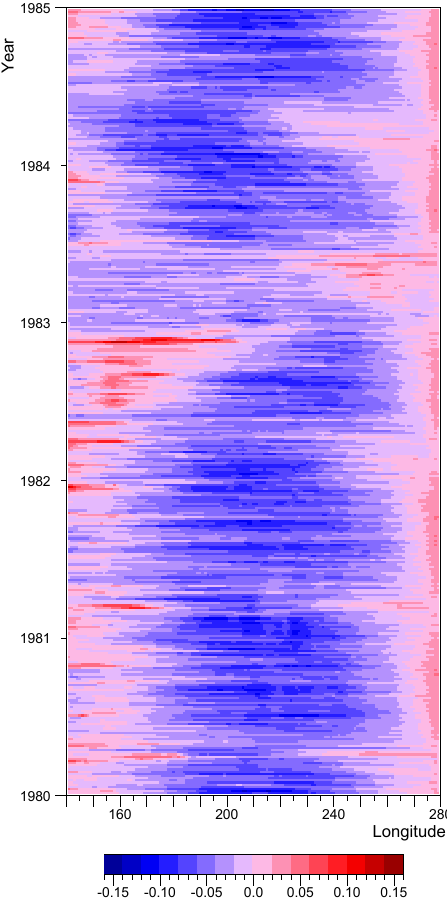
Figure 3. Eastward component of wind stress (Pa) at the Equator between 140 and 280 ◦ E (80 ◦